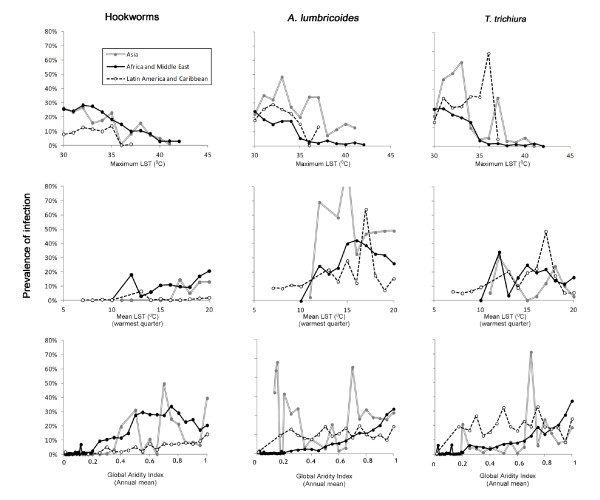
Relationship between climatic factors and prevalence of STH infection. Climatic factors estimated from interpolated weather station data, and prevalence of STH infection from 4,840 unique survey locations world-wide, stratified by world region. Estimates were derived for each survey point location and data for locations experiencing the same temperature are averaged for presentation.